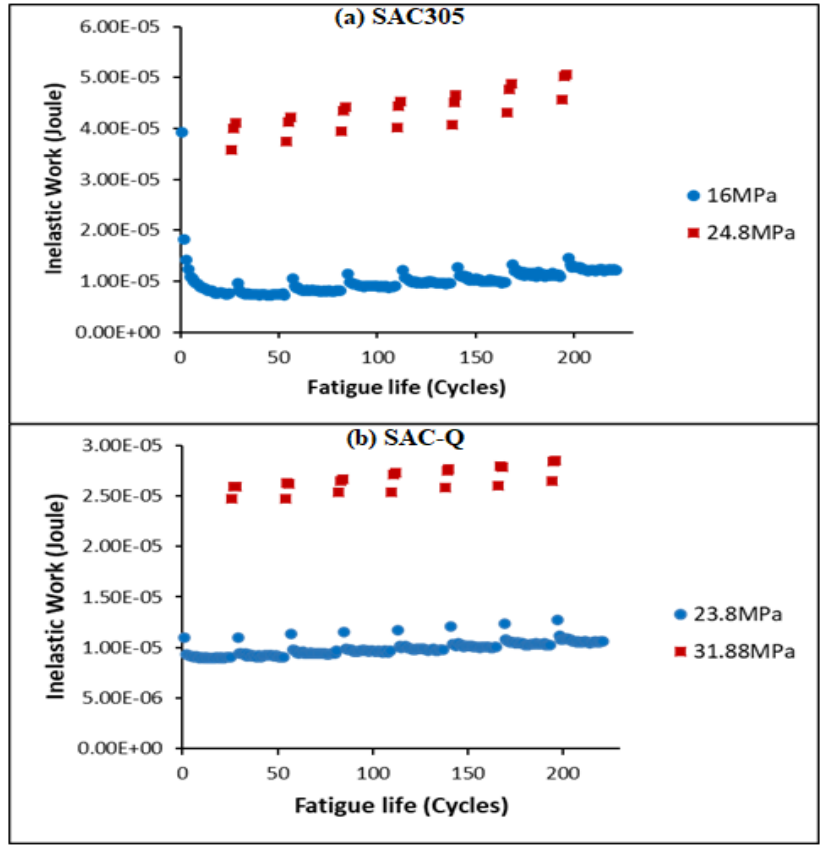
Figure 8. Example of inelastic work of ( a ) 10 h aged SAC305 under varying stress amplitude (16 MPa–24.8 MPa); ( b ) 1000 h aged SAC-Q varying stress amplitude (23.8 MPa–31.88 MPa).